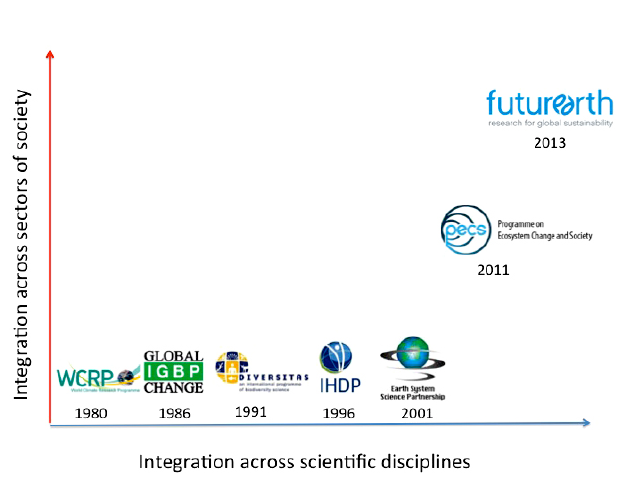
Fig. 1. The evolution of global research projects and the case of the Programme for Ecosystem Change and